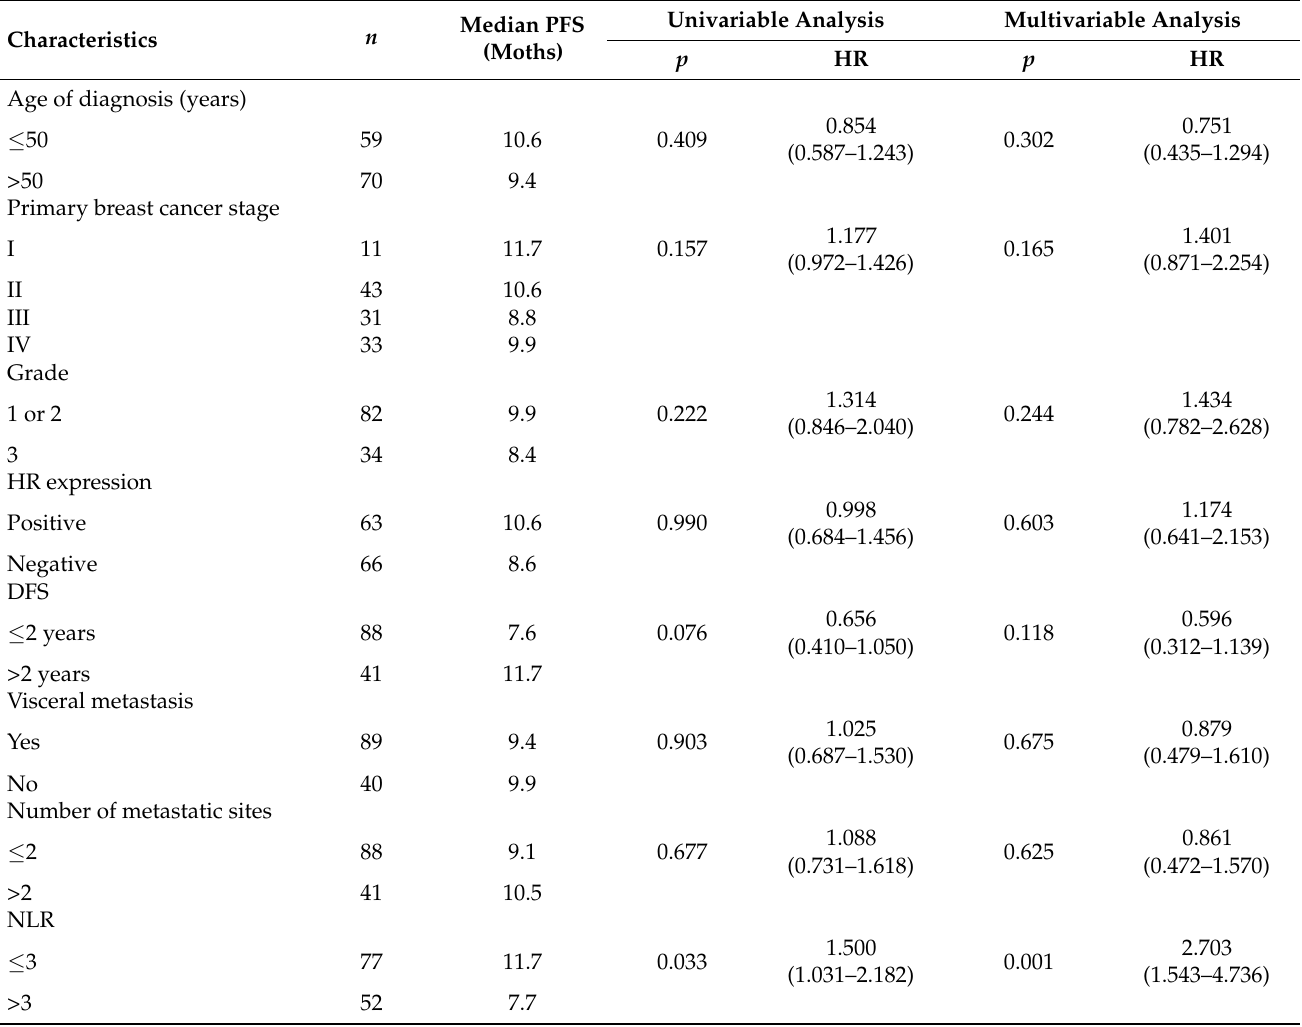
Table 3. Univariable and multivariable analysis of progression-free survival.